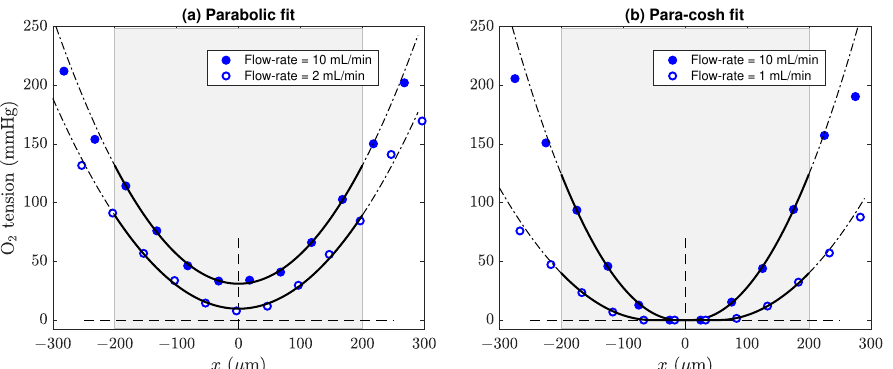
Figure 3. Parabolic and para–cosh curve fits for four representative tension vs. depth profiles measured from healthy slices of mouse brain tissue at room temperature ( ∼ 20 ◦ C). The grey shading indicates the 400- µ m extent of the slice for − 200 ≤ x / µ m ≤ 200, with x = 0 µ m marking the central plane of symmetry of the slice. ( a ) Parabolic profiles showing no restriction of metabolic rate. ( b ) Insufficient oxygen tension leads to flattened profiles with a cosh-modulated central basin joined to parabolic wings to the left and